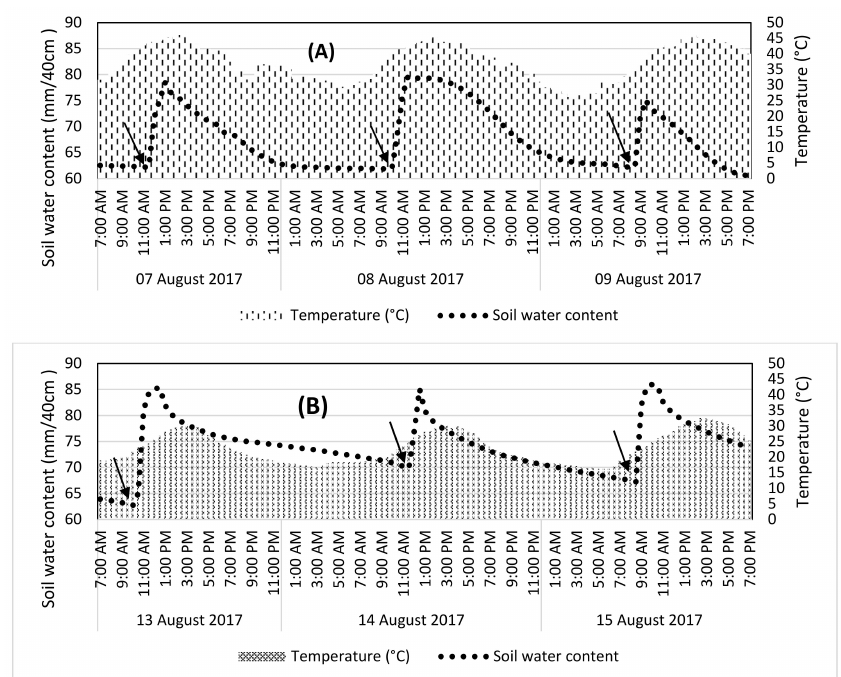
Figure 3. ‘Orogrande’ clementine soil volumetric water content in the upper 40-cm soil profile for three consecutive high-temperature days (7–9 August); ( A ) and three consecutive mild-temperature days (13–15 August); ( B ) for Cntl trees receiving full irrigation. Arrows indicate the time of water supply. Capacitance probe measurements were recorded every 15